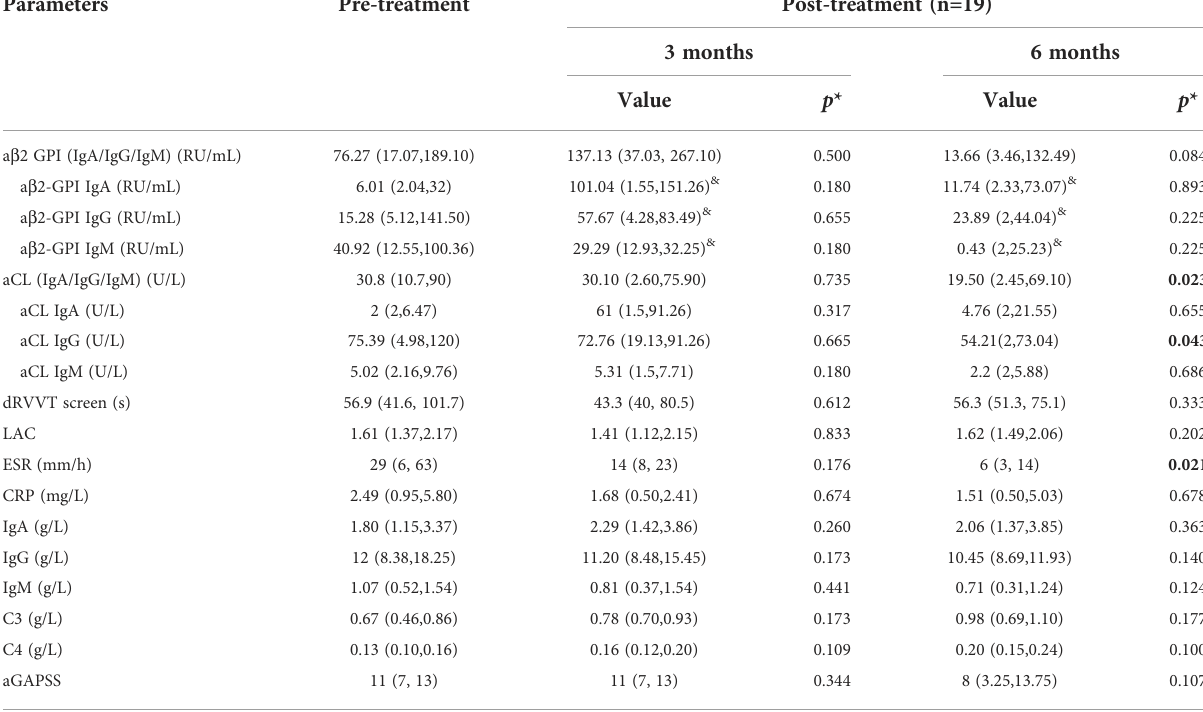
TABLE 3 Pro fi les of laboratory parameters following rituximab treatment.